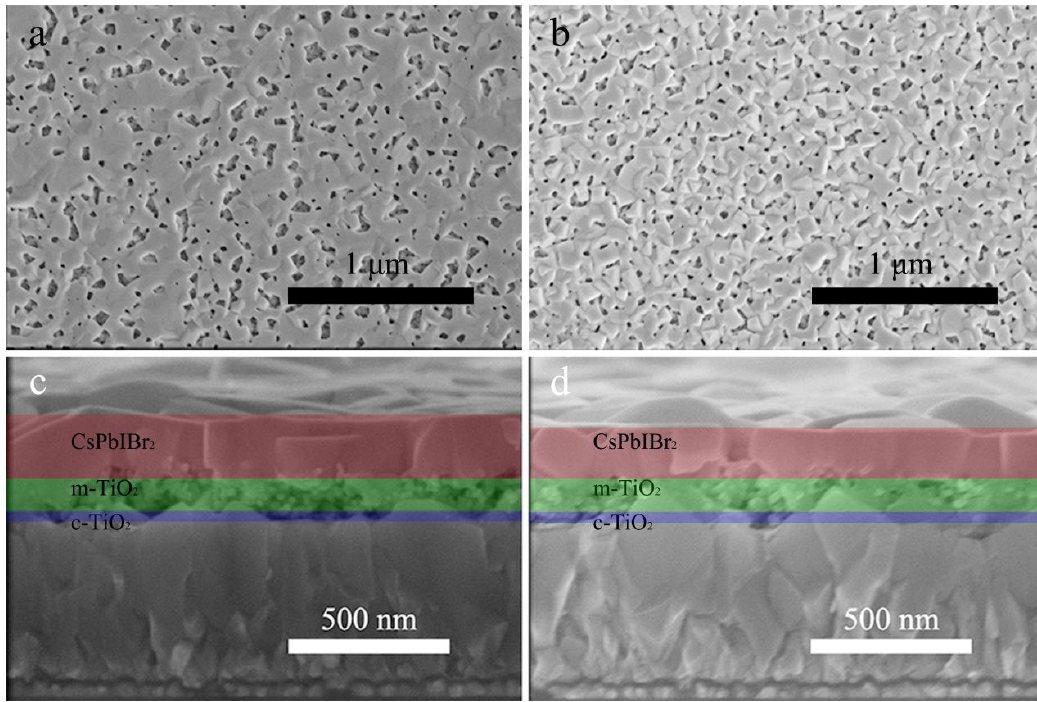
Figure 2. Top-view SEM images and cross-sectional SEM images of m-TiO 2 /CsPbIBr 2 films ( a , c ) without and ( b , d ) with PED.